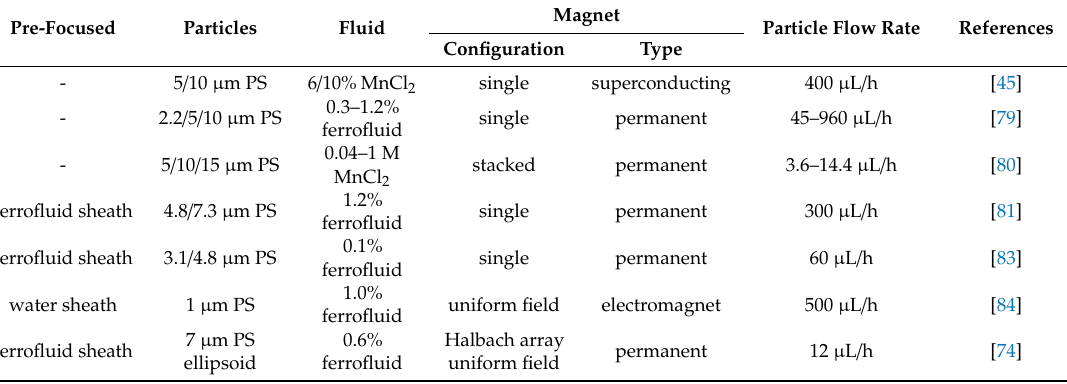
Table 1. Summary of the published papers on diamagnetic particle deflection in magnetic fluid flows.